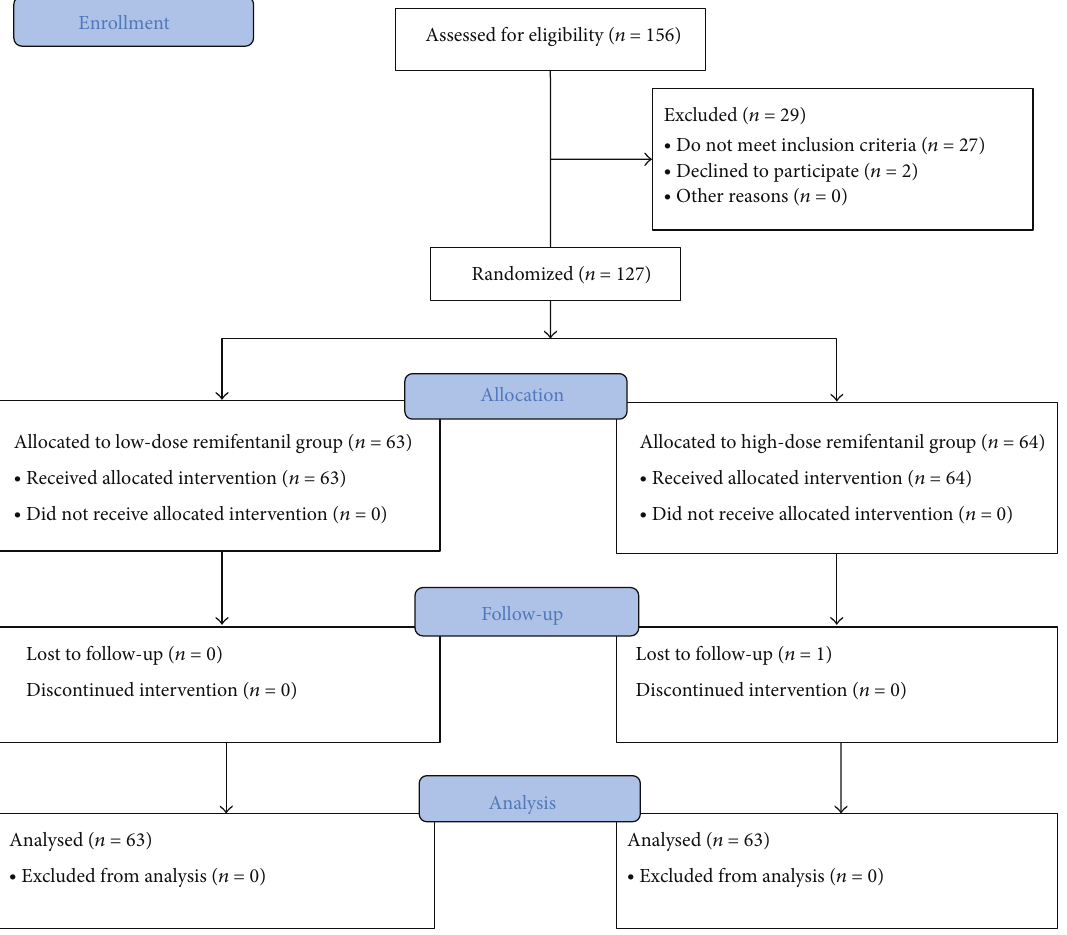
Figure 1: CONSORT flow diagram for the study.